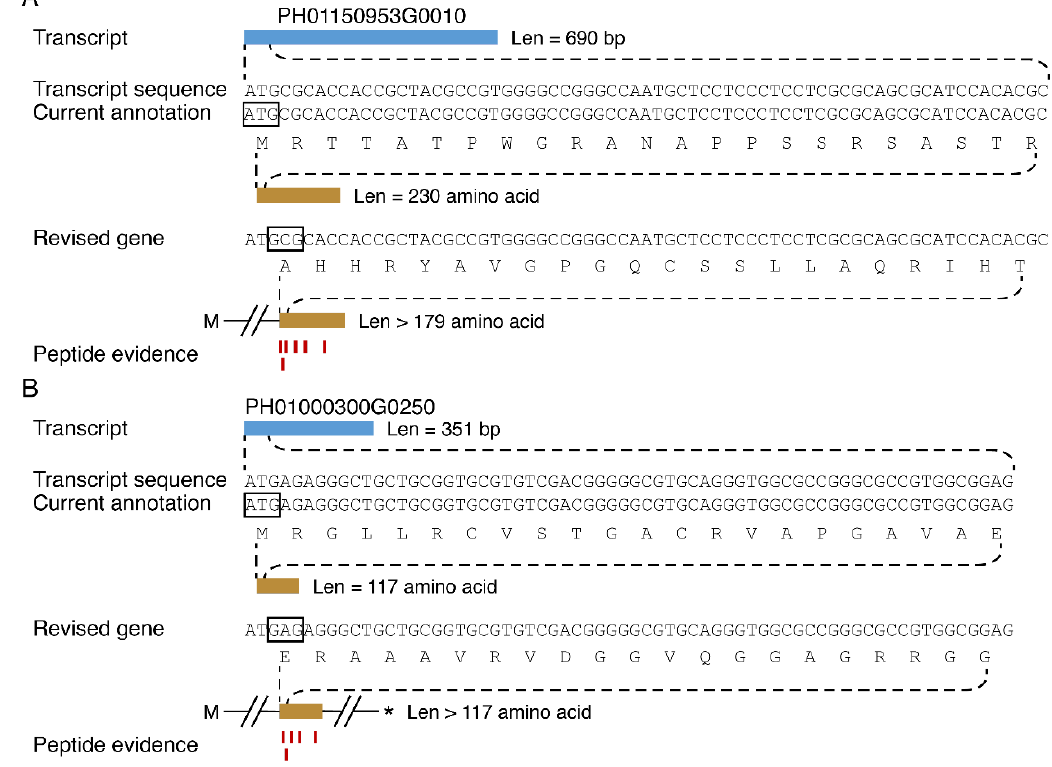
Figure 4. Revision of gene annotation in moso bamboo and discovery of new genes. Current annotation and translation frame (black frames) and revised gene models of PH01150953G0010 ( A ) and PH0100300G0250 ( B ) supported by matching peptide spectra. Stop codon was marked by an asterisk.